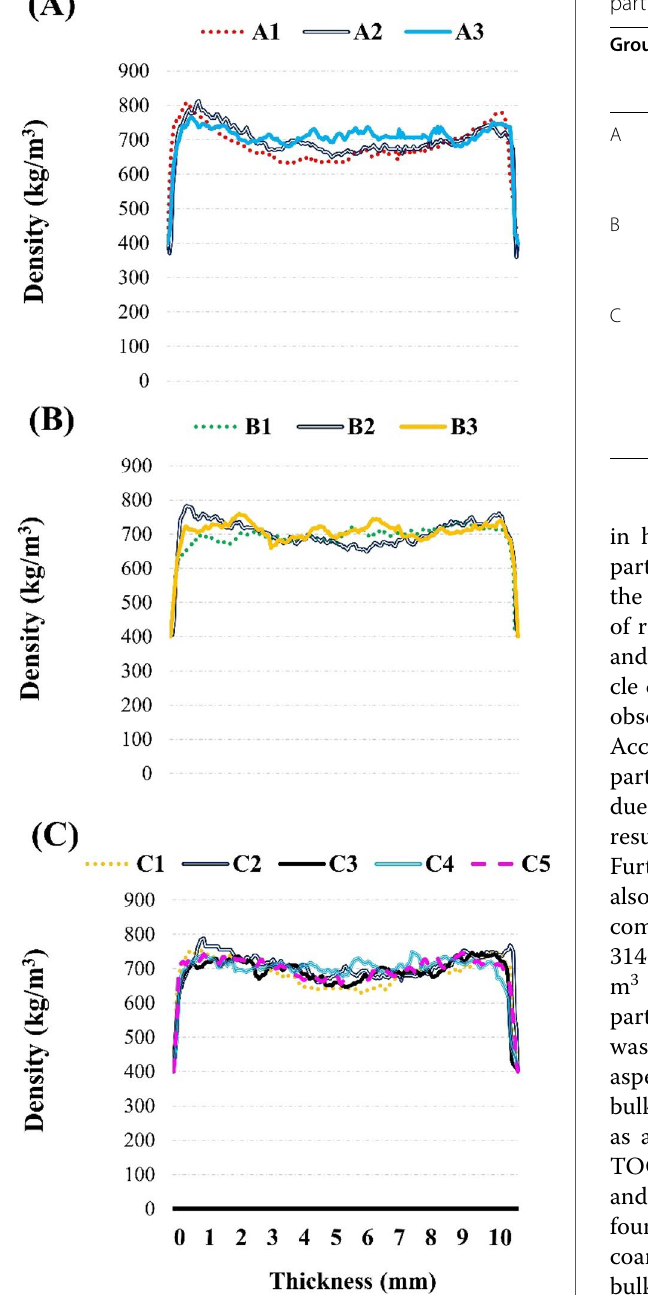
Table 4 Density and compaction ratio of different